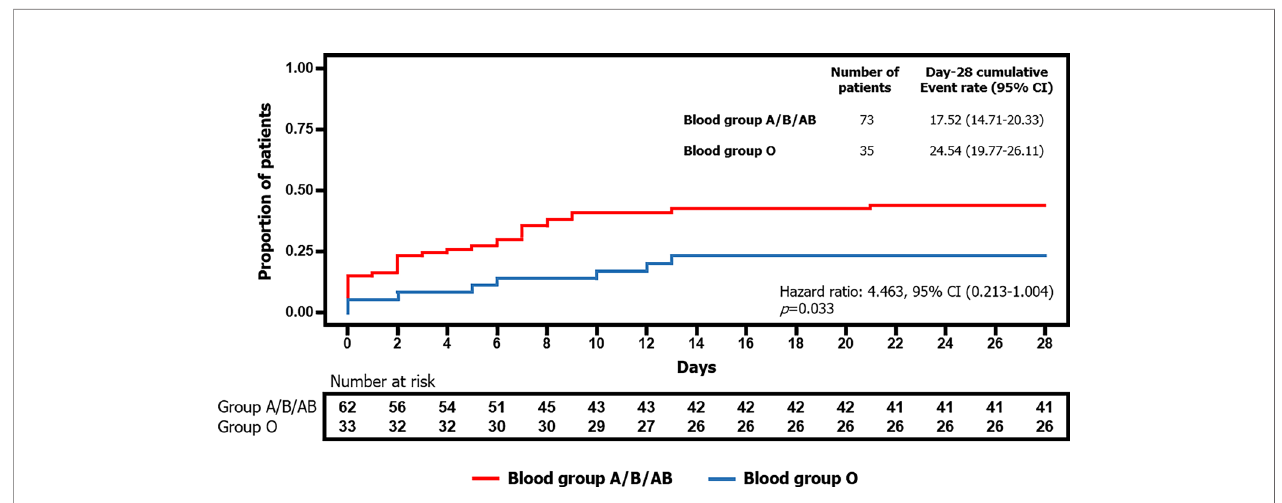
FIGURE 1 | Differences in time to mechanical ventilation or death by day 28 depending on blood group A/B/AB or blood group